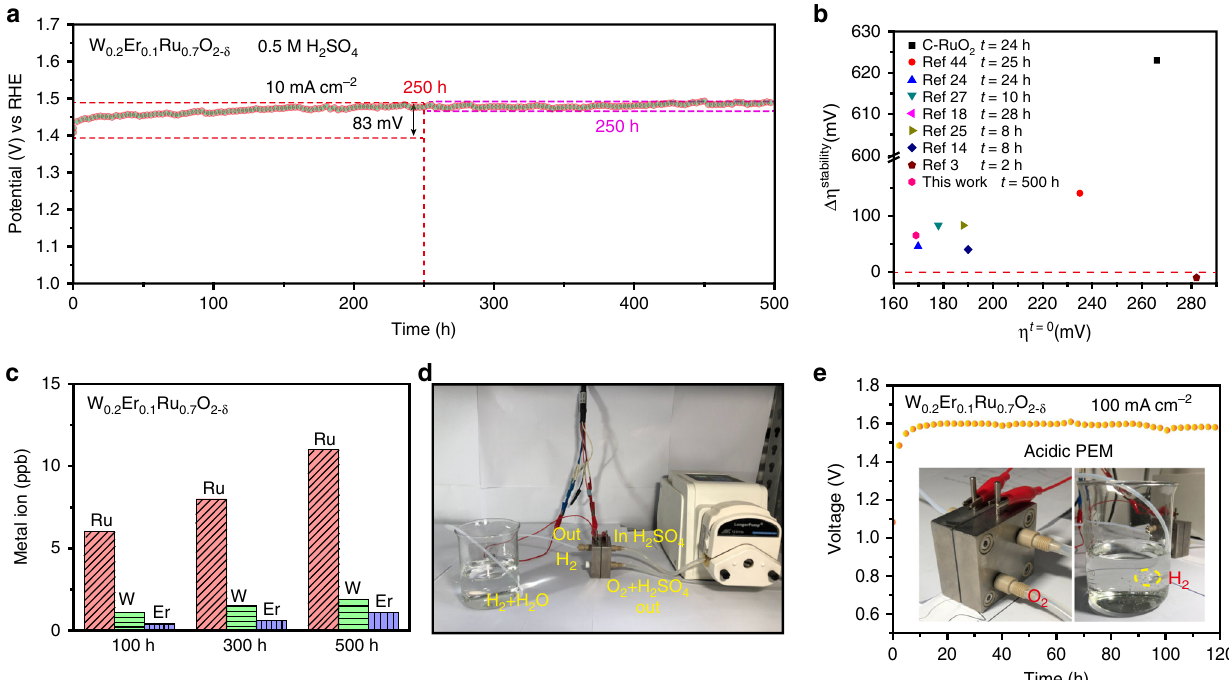
Fig. 7 The long-durable stability investigation for OER and PEM in acidic electrolyte. a The current-time (500 h) stability of W 0.2 Er 0.1 Ru 0.7 O 2 − δ nanosheets in 0.5 M H 2 SO 4 . b The comparison of stabilities in acidic electrolyte for various electrocatalysts, x -axis stands for the initial ɳ for electrocatalysts reaching 10 mA cm − 2 , y- axis represents the fi nal ɳ of various electrocatalysts after stability measurement. c ICP analysis for W 0.2 Er 0.1 Ru 0.7 O 2 − δ after 500 h operation in acidic electrolyte. d Photograph of the employed PEM reaction device. e The current – time (120 h) stability of W 0.2 Er 0.1 Ru 0.7 O 2 − δ as anodic side in acidic PEM (inset: PEM reaction device, detection of H 2